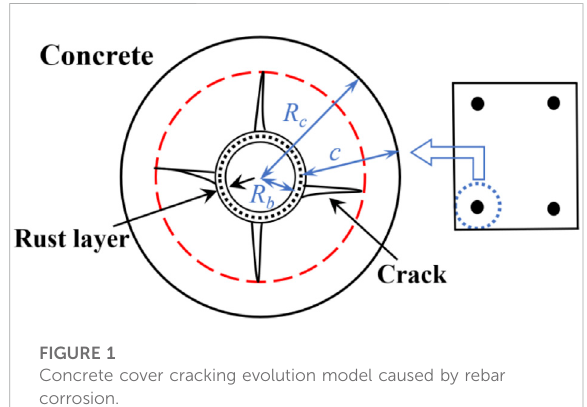
FIGURE 1 Concrete cover cracking evolution model caused by rebar